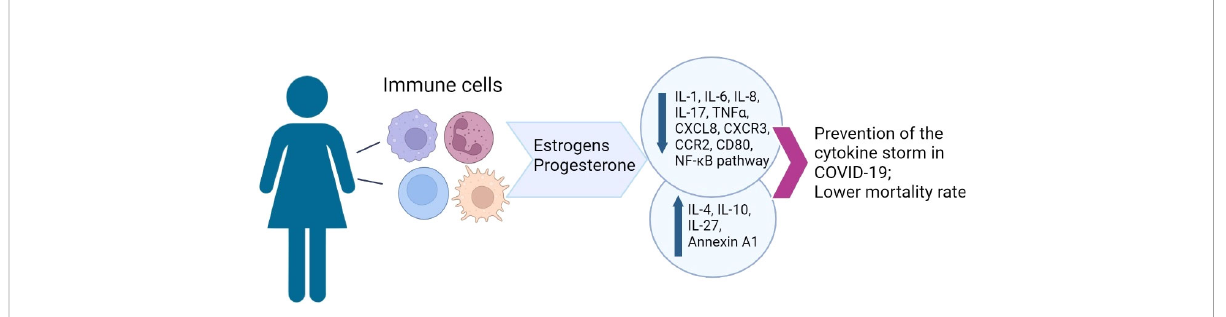
FIGURE 1 A graphical summary of sex hormone effects on female